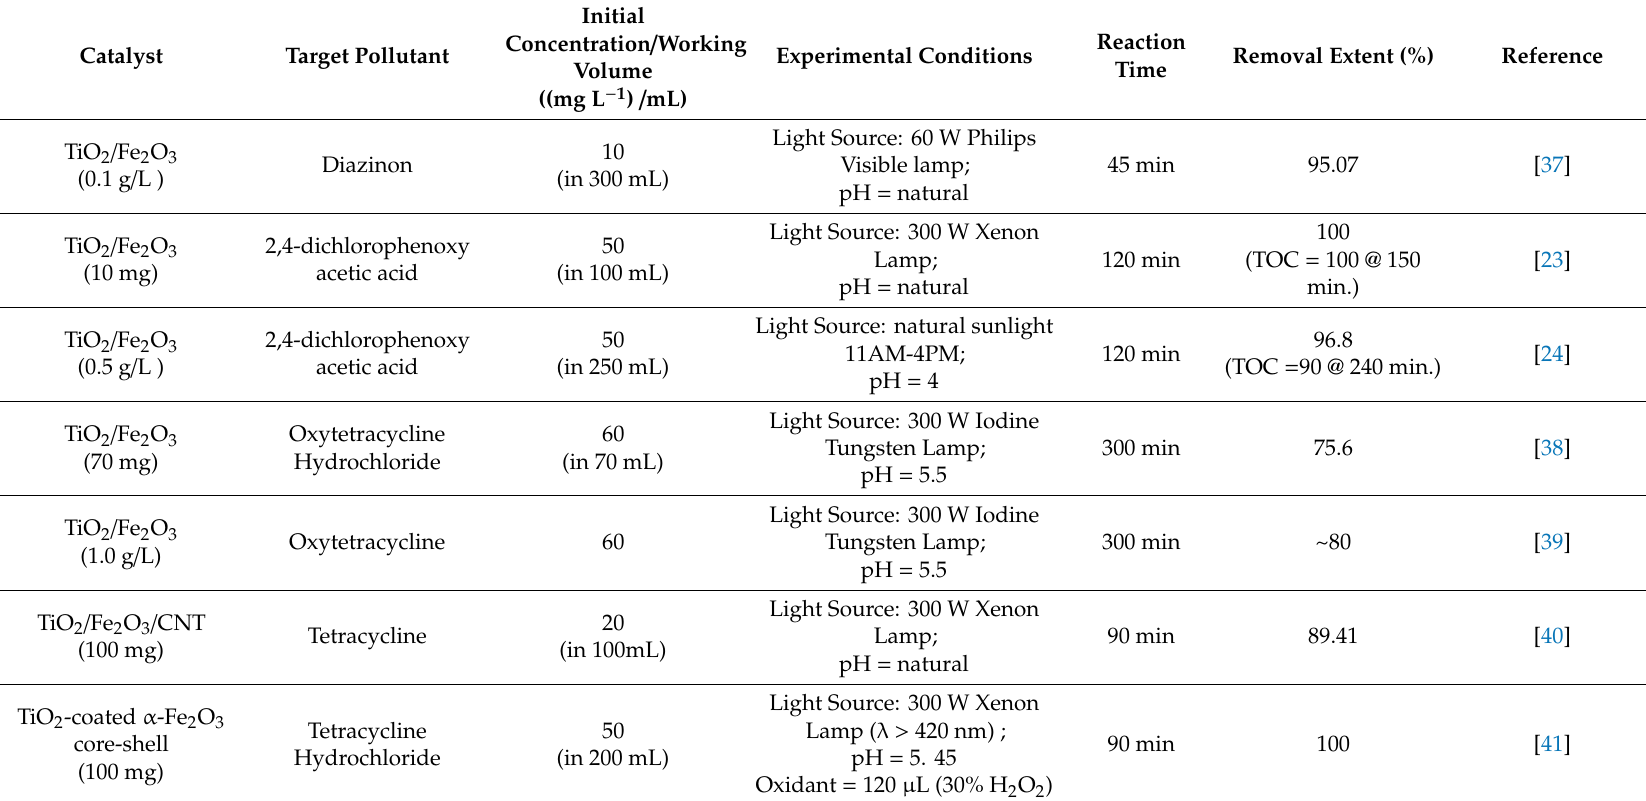
Table 2. Photocatalytic degradation of CEC’s over TiO 2 / Fe 2 O 3